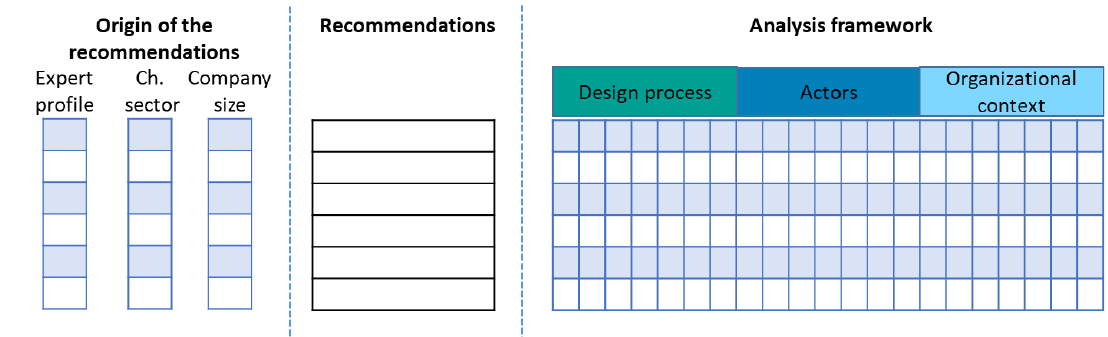
Figure 10. Structure of the information for using the knowledge base. Figure 9. Structure of the information for using the knowledge base.